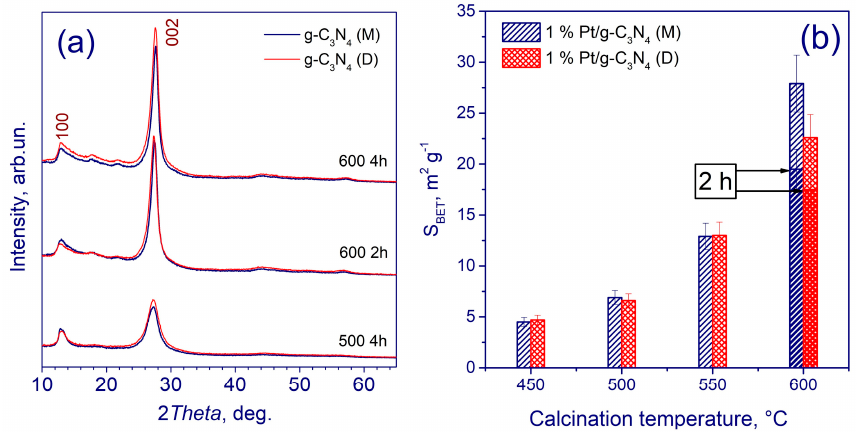
Figure 3. ( a ) XRD patterns of g-C 3 N 4 . ( b ) Specific surface area photocatalysts obtained from melamine (M) and dicyandiamide (D). Adapted with permission from Ref. [76]. 2021, Elsevier.